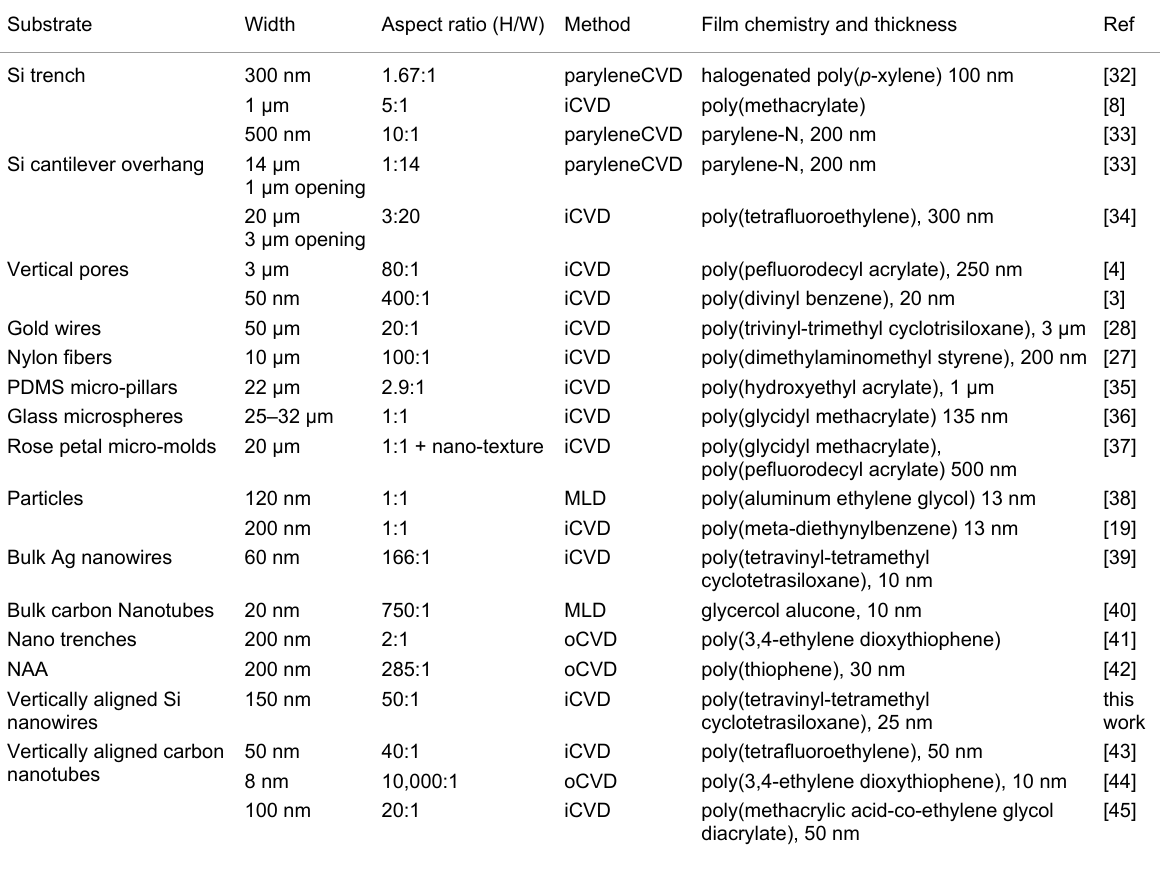
Table 1: Vapor deposited conformal polymer films by substrate, relevant length scale, method, and polymer chemistry. Substrate